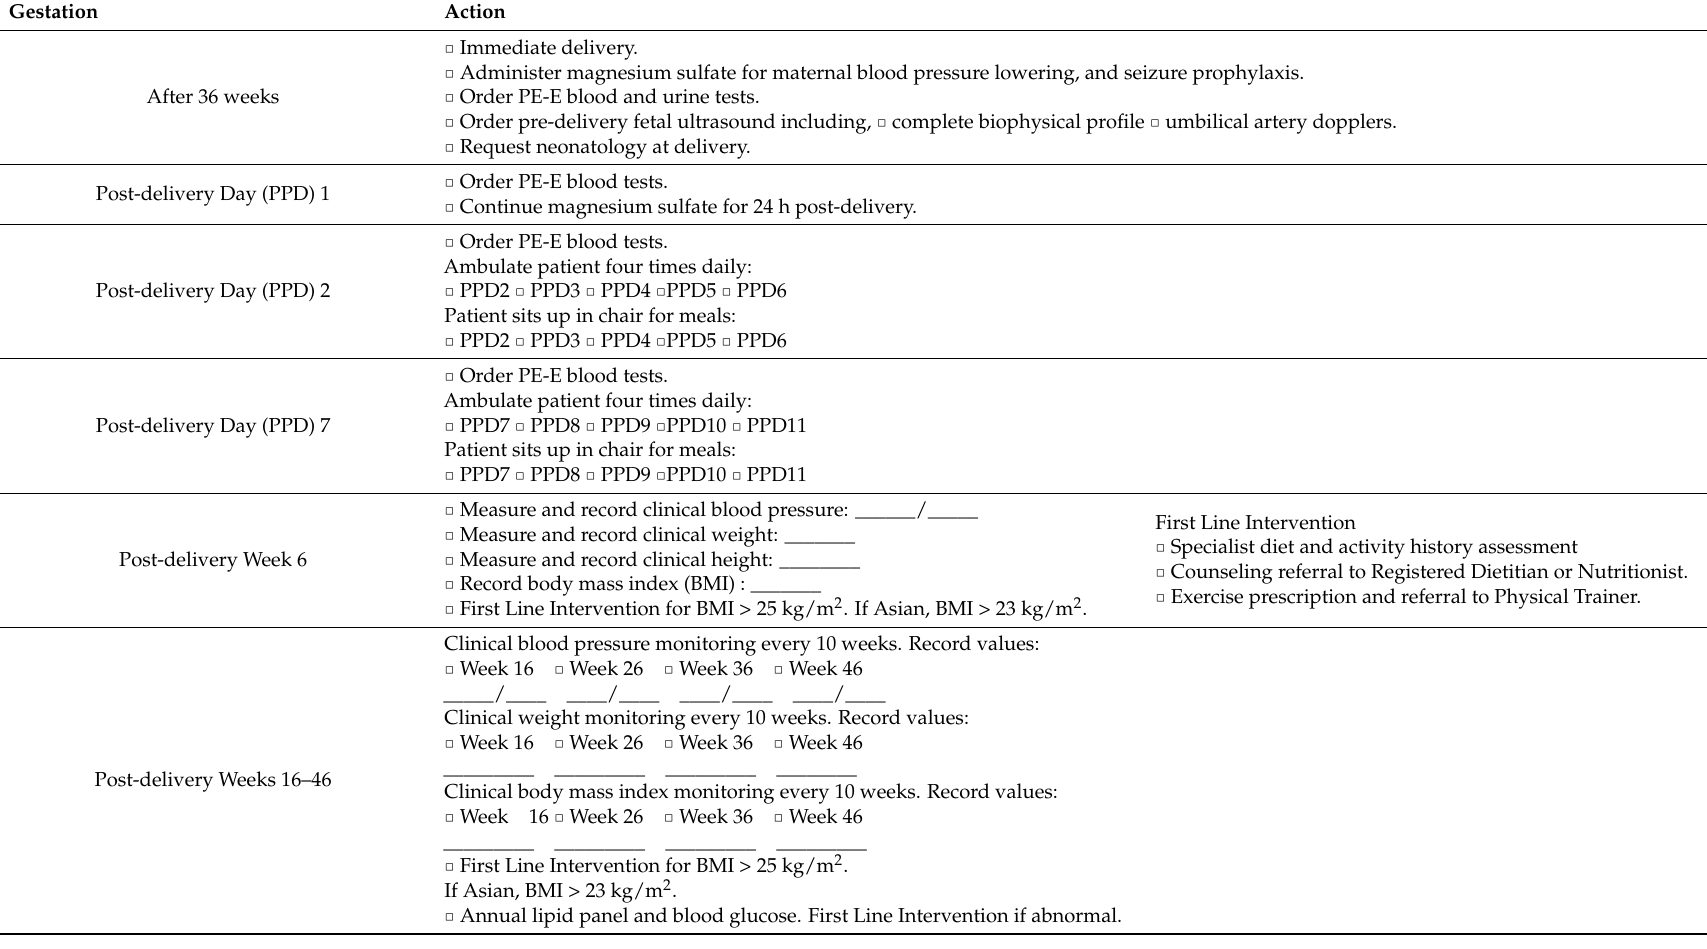
( C ) Term and fourth trimester